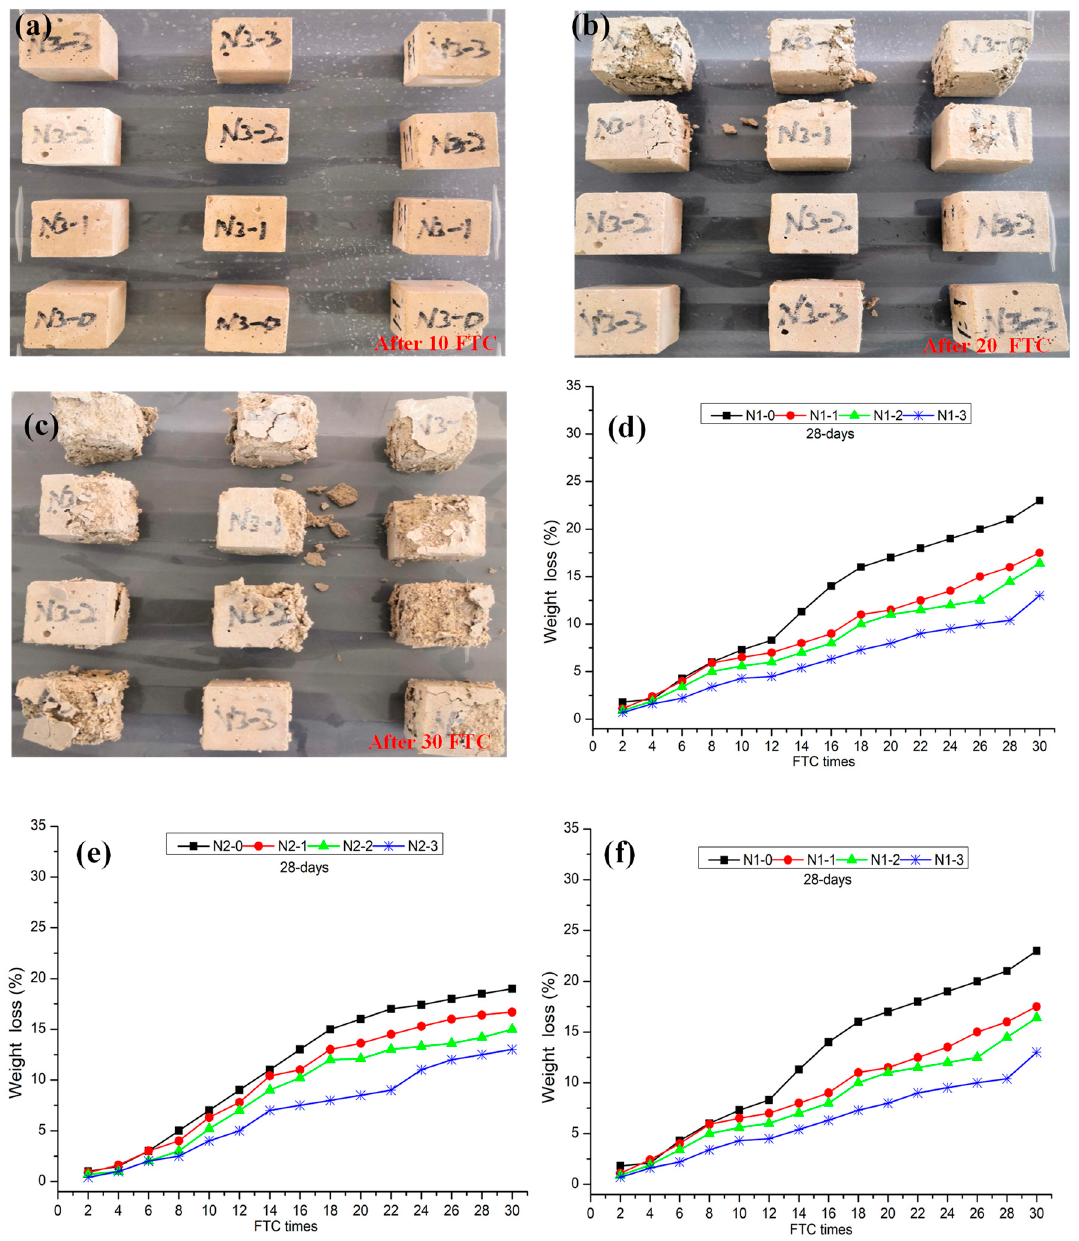
Figure 9. Photographs of the group N3 after FTC tests: ( a ) After 10 FTC, ( b ) After 20 FTC, ( c ) After 30 FTC. Weight loss with FTC for NHL-based mortar: ( d ) Group N1, ( e ) group N2, and ( f ) group N3.